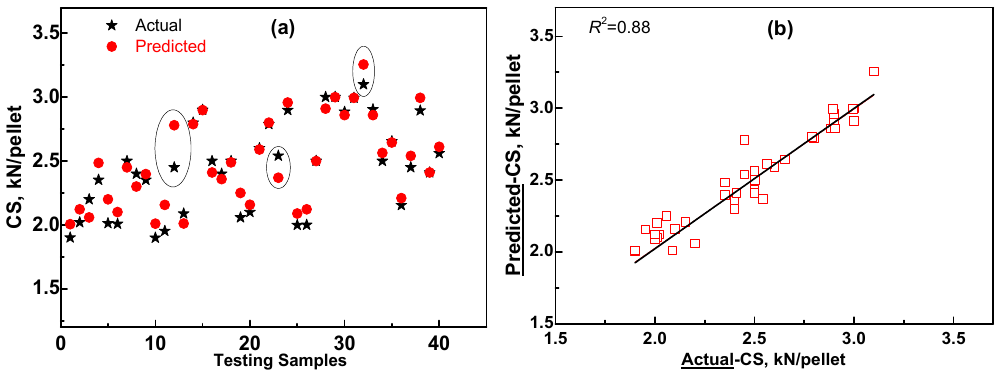
Figure 7. Testing results of PCA-GA-BP network for CS ( a ) Actual Vs Predicted results through ANN; ( b ) Actual Vs Predicted results for CS.